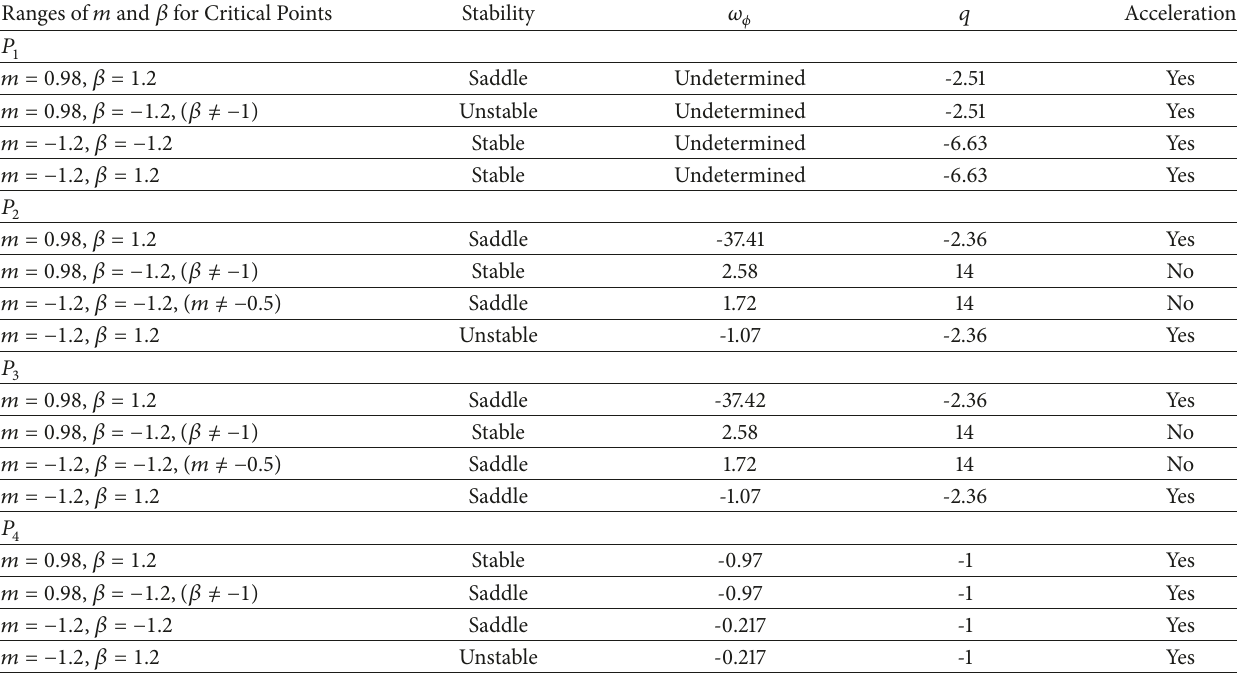
Table 2: Phase Space Analysis for the Phantom Coupled System with 𝑄 = 𝛽 ̇𝜎 𝜙 . Ranges of 𝑚 and 𝛽 for Critical